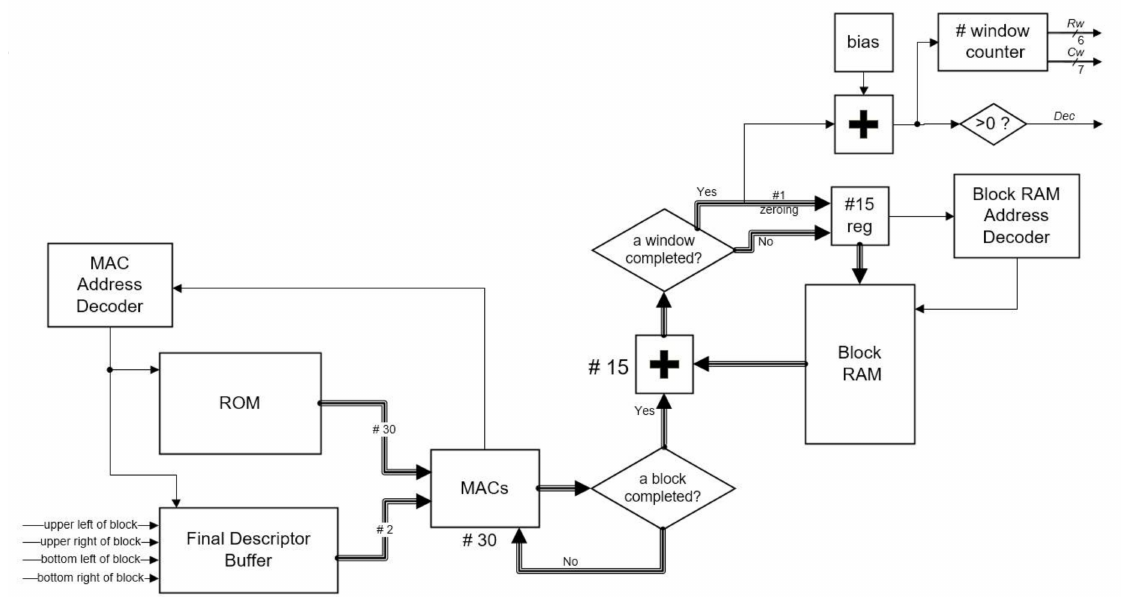
Figure 7. Diagram of the SVM classification in the proposed